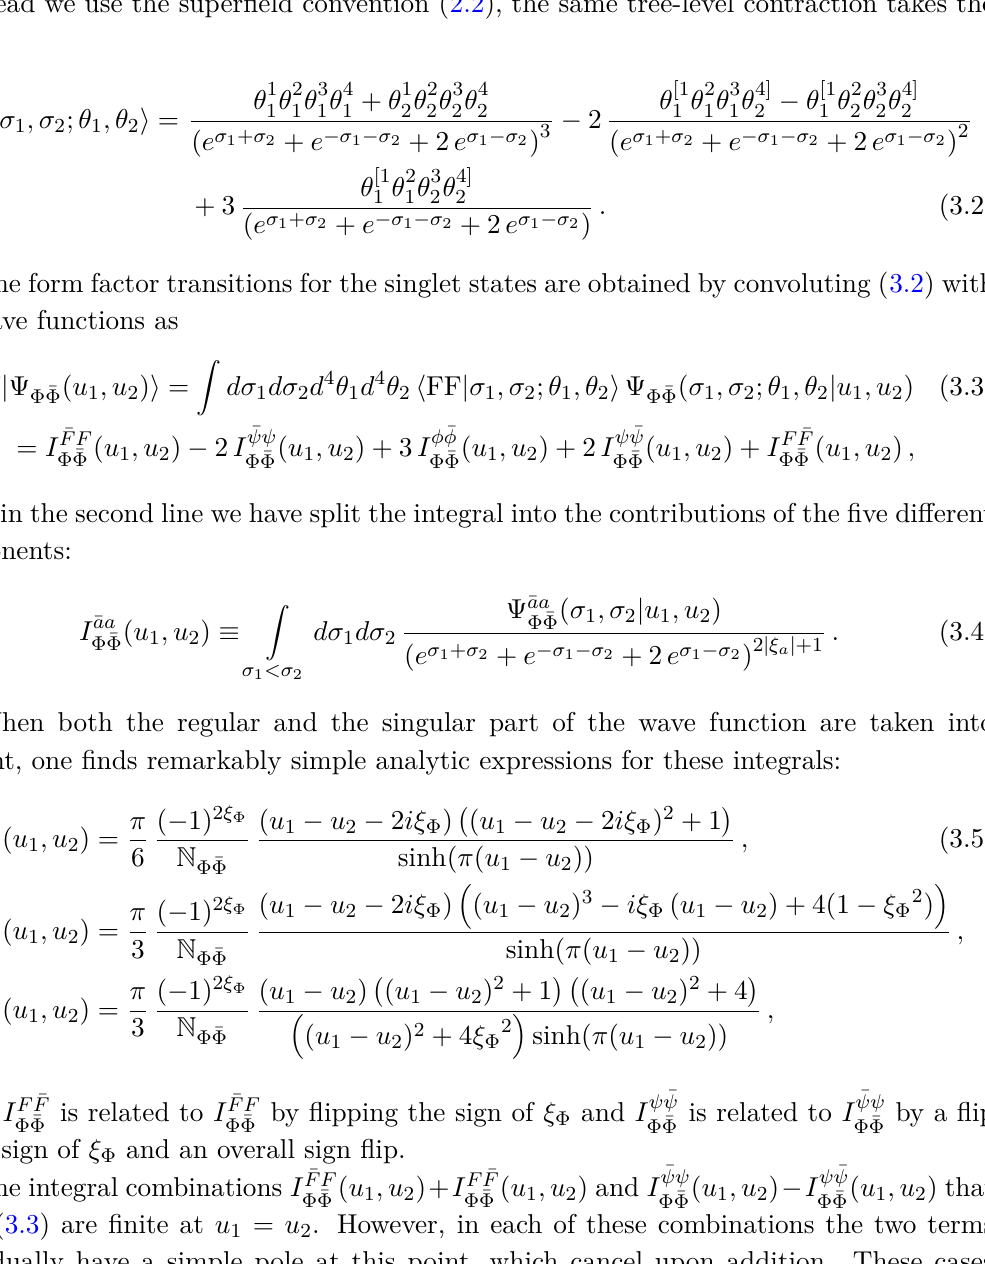
Figure 4 . At Born level, the FF transition for a pair of conjugate fields, Φ 1 = Φ( x ( σ 1 )) and ¯Φ ¯Φ( x ( σ 2 = 2 )) , is given by the free propagator between If instead we use the superfield convention (2.2), the same tree-level contraction takes